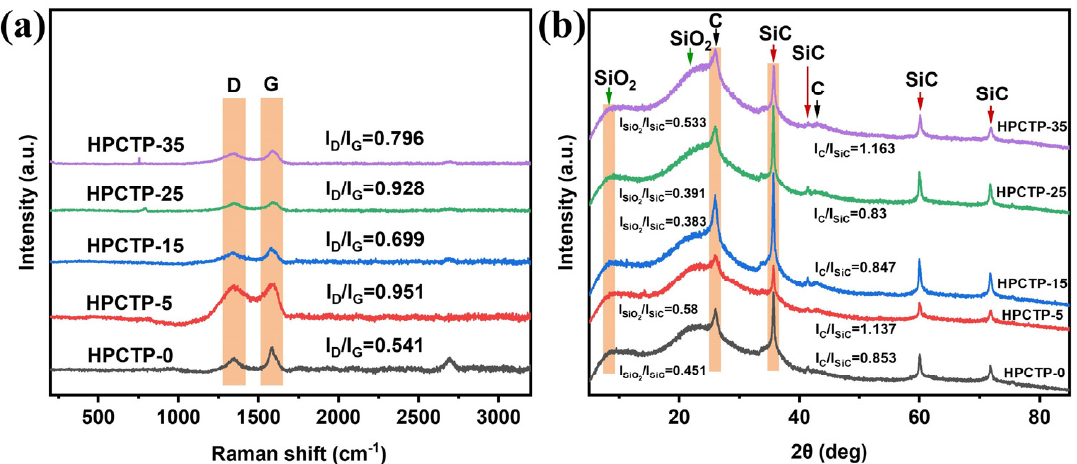
Figure 8. Char layer of HPCTP-containing EMVSR composites after ablation tests: ( a ) Raman spectra; ( b ) XRD curves.